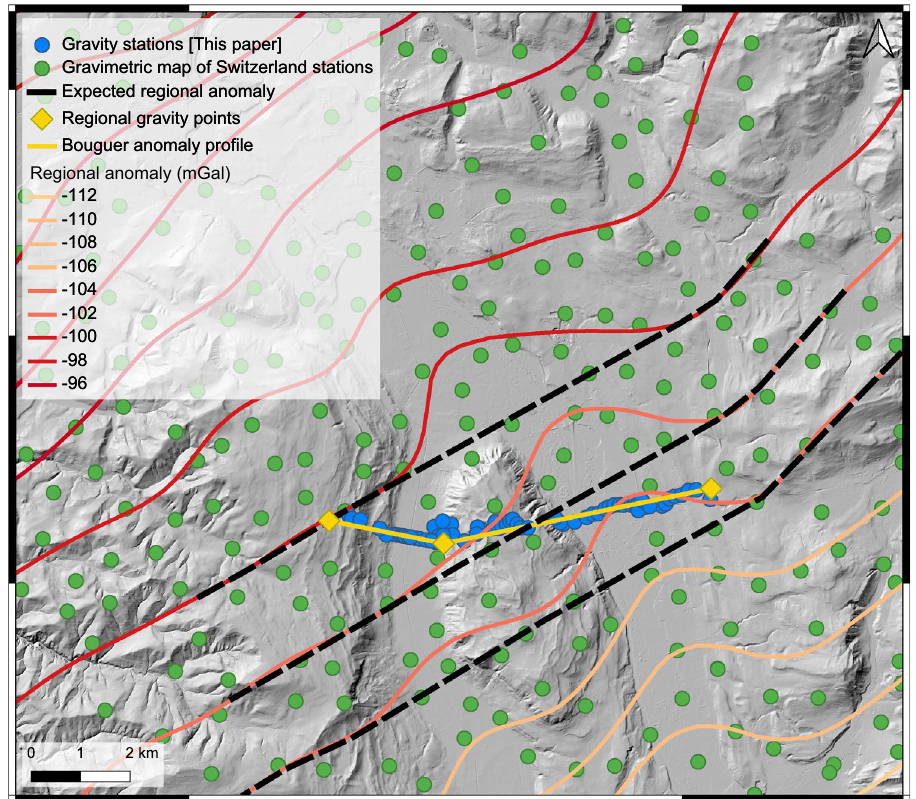
Figure 3. Gravity data. Regional gravity map, Bouguer anomaly contour lines and location of our stations. The map and the contour lines are from the openly accessible database of swisstopo (‘Carte gravimétrique de la Suisse (Anomalies de Bouguer) 1: 500,000, © swisstopo) 27 . The dashed black line indicates the estimated regional trend where the local anomalies related to the overdeepening fills have been removed. The yellow line shows the location of our section. The yellow diamonds indicate locations where our section starts or where it changes the direction. At these sites, we extracted the values of the regional gravity trend along the dashed black line, which is illustrated in Fig.